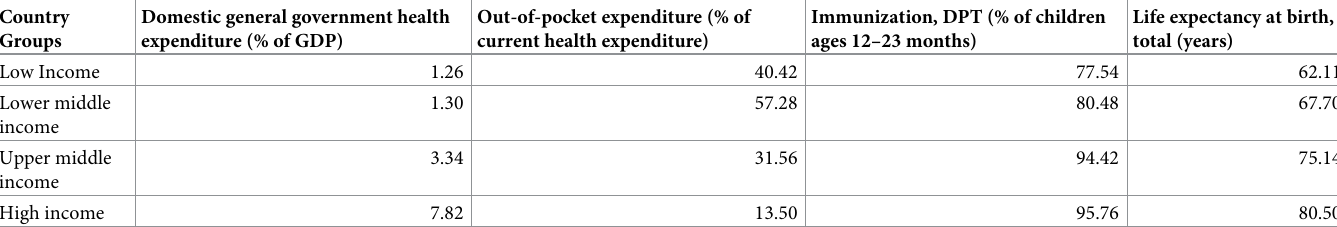
Table 8. Health expenditure and health status in country